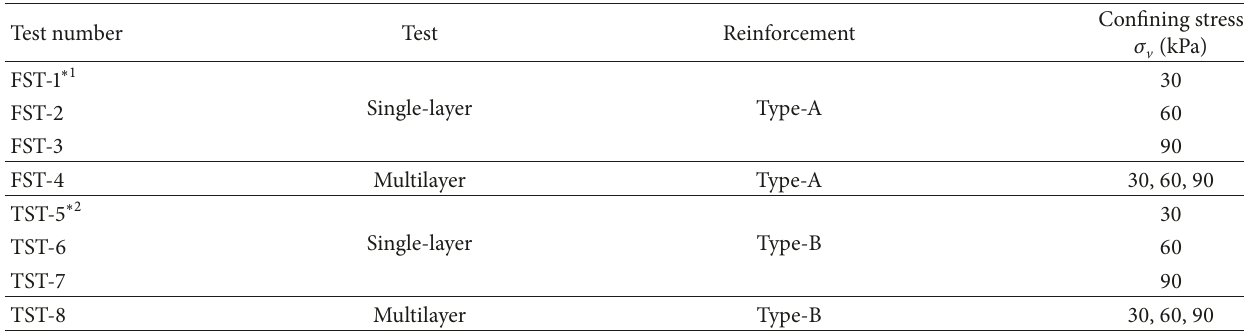
Table 5: Conditions of pullout test.